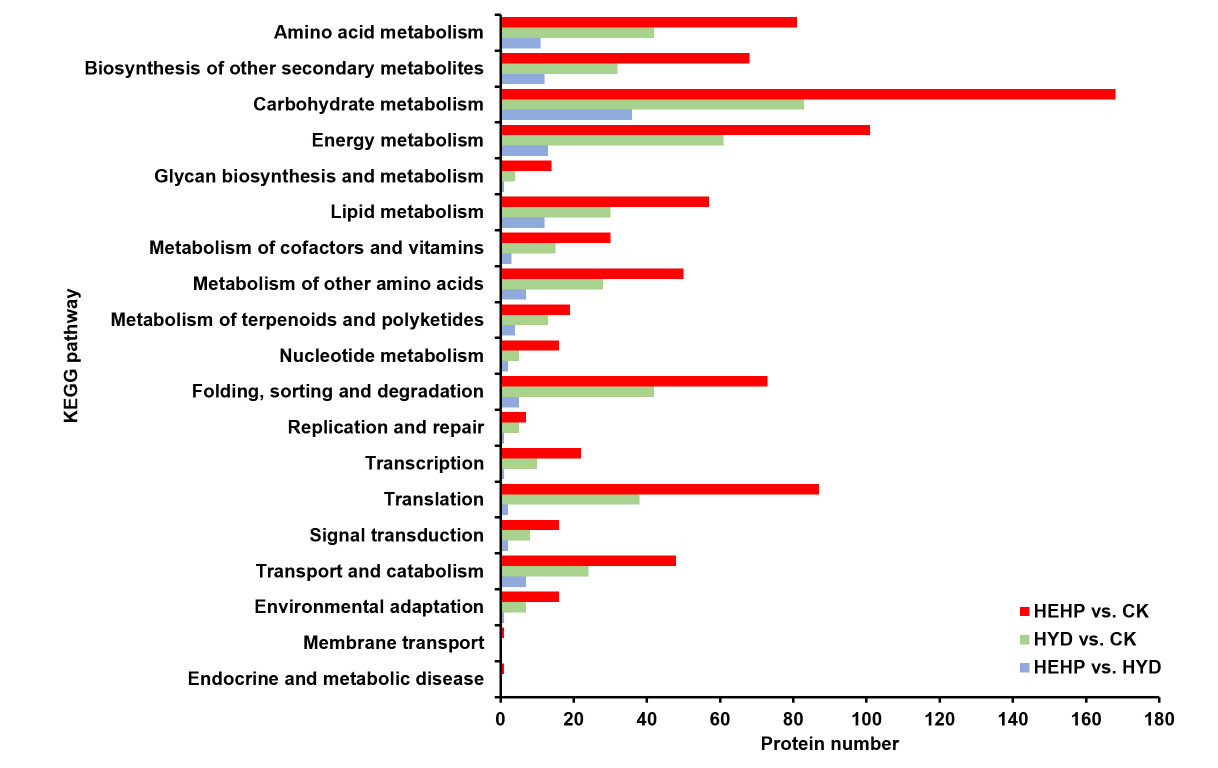
all the groups (HEHP vs. CK, HYD vs. CK and HEHP